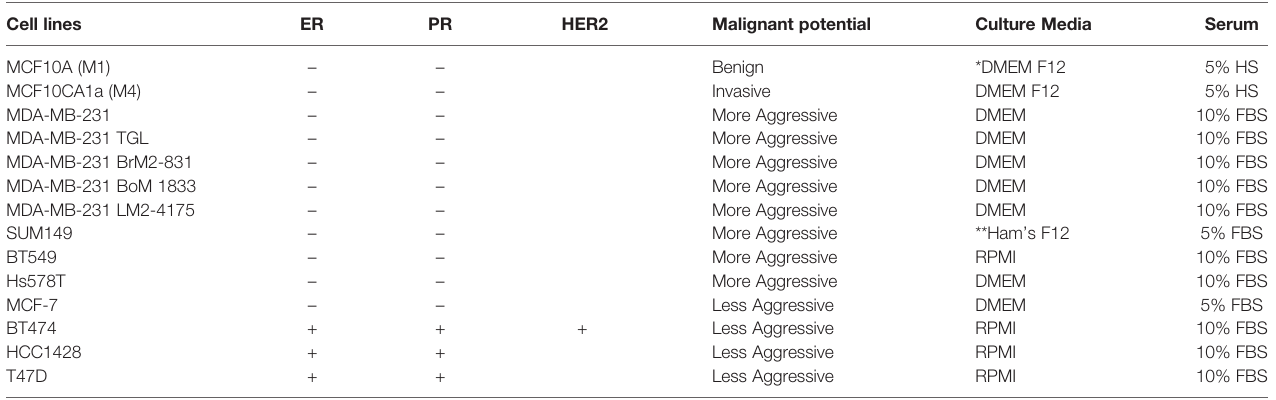
TABLE 1 | Characteristics and culture conditions of the cell lines used in this study. Cell